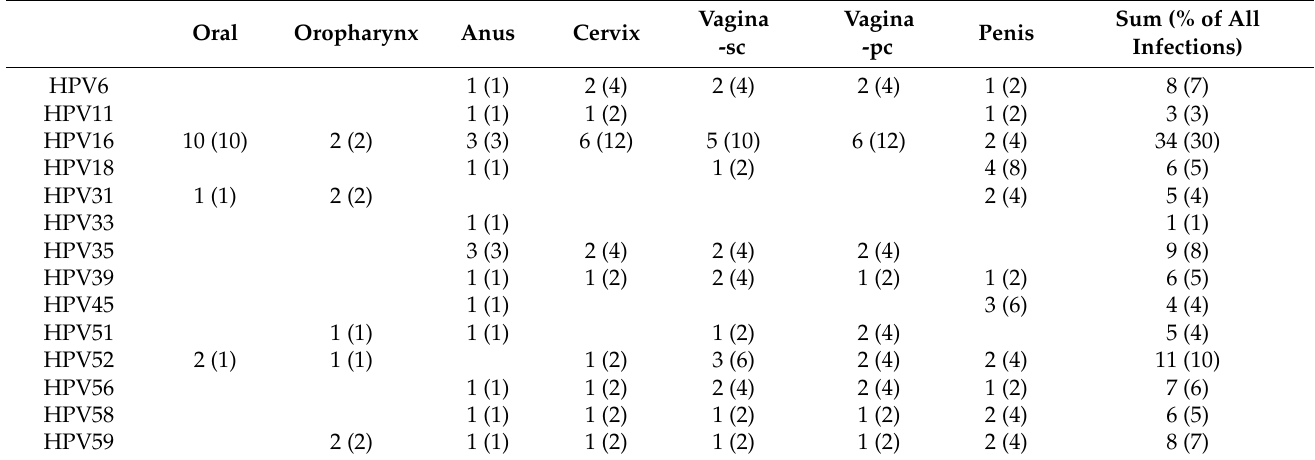
Table 2. HR- and LR-HPV infections in different mucous membranes; n